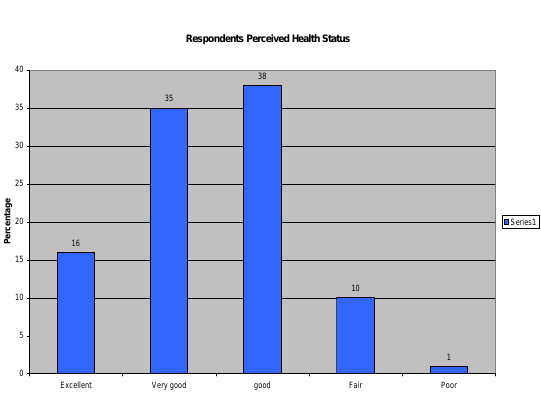
Figure 3: Source: Based on survey result by the author Majority of the respondents perceived themselves as being in good to excellent